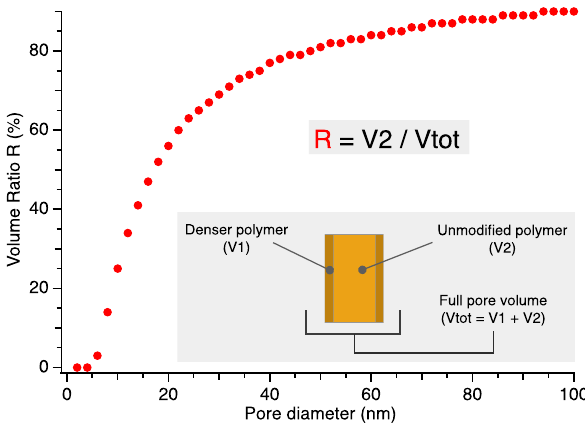
Figure 5. Evolution of the ratio R between the unmodified polymer volume V2 to the full pore volume Vtot as a function of the pore diameter. The symbols are defined in the figure inset. Larger pore diameters lead to higher R, with the highest sensitivity in the 5–30 nm diameter range.